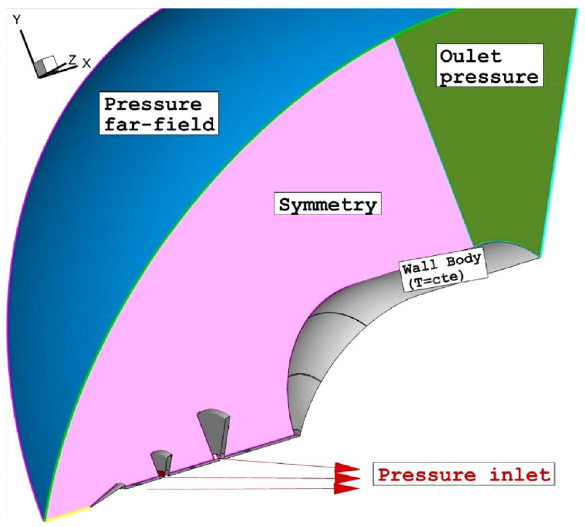
Figure 2. Applied boundary condition.